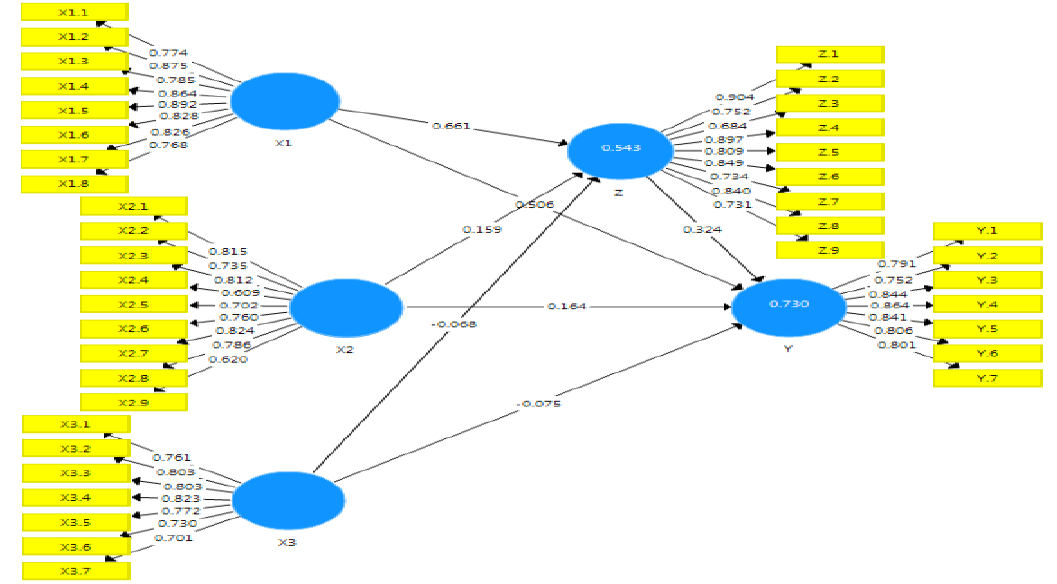
Figure 1: Diagram of Hypothesis Testing; Source: Smart PLS Output,